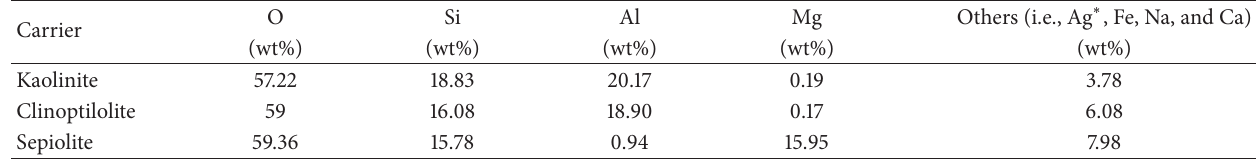
Table 5: EDX analysis results of the physically treated clays after 30 days of exposure to water media.